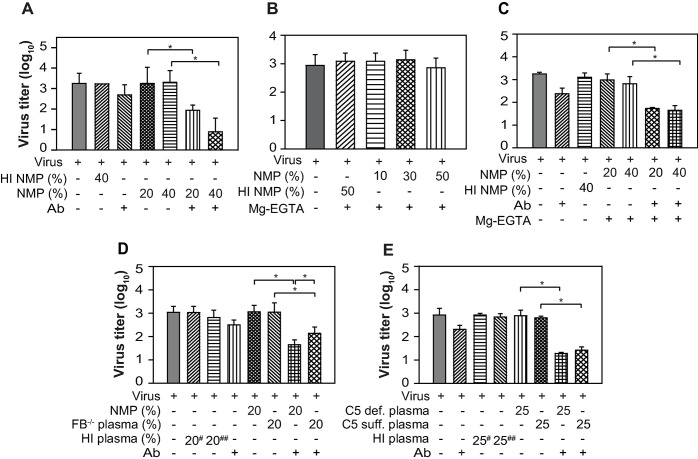
A(H1N1)pdm09 virus is susceptible to the classical pathway, but resistant to the alternative pathway-mediated neutralization unless coated by antibodies.A) CP-mediated neutralization of A(H1N1)pdm09 virus. The virus was incubated with normal mouse plasma (NMP; 20% & 40%; B6 mice) in the presence or absence of antibody, and the infectious virus remained was determined by TCID50. B) AP-mediated neutralization of the virus. The virus was incubated with the various concentrations of normal mouse plasma (10%, 30% or 50%; B6 mice) in the presence of 20 mM Mg-EGTA and the remaining virus was titrated by TCID50. C) AP-mediated neutralization of A(H1N1)pdm09 virus in the presence of virus specific antibodies. The virus was incubated with two different concentrations of normal mouse plasma (20% and 40%; B6 mice) in the presence of antibody and Mg-EGTA, and the remaining virus was titrated by TCID50. D) Contribution of the AP amplification loop during the CP-mediated neutralization of A(H1N1)pdm09 virus. The virus was incubated with WT or FB-/- mouse plasma (20%; B6 mice) in the presence of antibody and Ca++ and Mg++, and the virus remained was determined by TCID50 analysis. (# HI—NMP; ## HI—FB deficient plasma). E) A(H1N1)pdm09 virus neutralization by C5 deficient mice plasma. The virus was incubated with C5 sufficient (25%; B10.D2/nSnJ) or C5 deficient (25%; B10.D2/oSnJ) mouse plasma in the presence of antibody and Ca++ and Mg++, and the remaining virus was titrated by TCID50. (# HI—nSn J; ## HI—oSnJ plasma). Results represent mean ± SD of three independent experiments. *p ≤ 0.05.